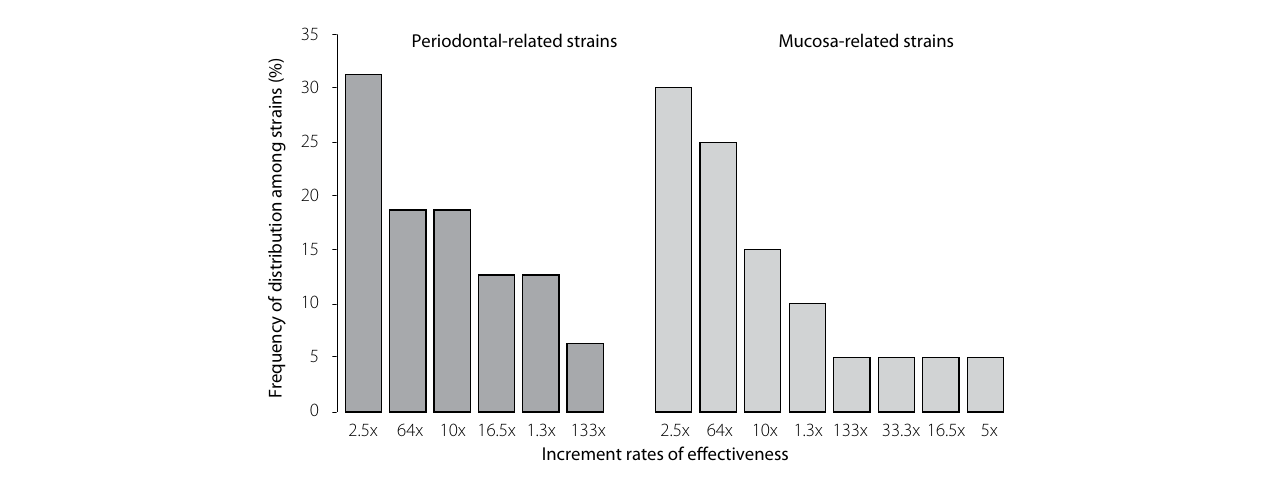
Figure 3. Increment rate of effectiveness (IRE) for minimal inhibitory concentrations (MIC) of chlorhexidine digluconate for periodontium-related (PP) and mucosa-related (OM) Candida albicans strains in normoxia and